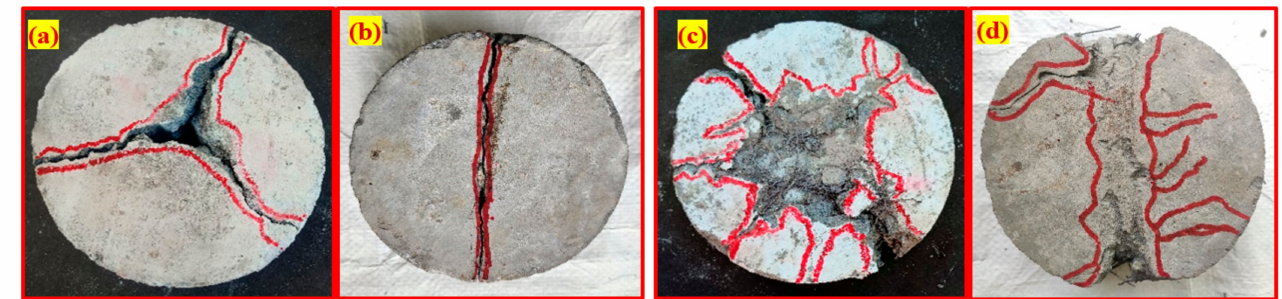
Figure 14. Comparison of failure pattern of specimens from ACI Committee 544 [38] and mod- ified falling mass impact test: ( a ) ACI-nonfibrous, ( b ) modified-nonfibrous, ( c ) ACI- fibrous, ( d )